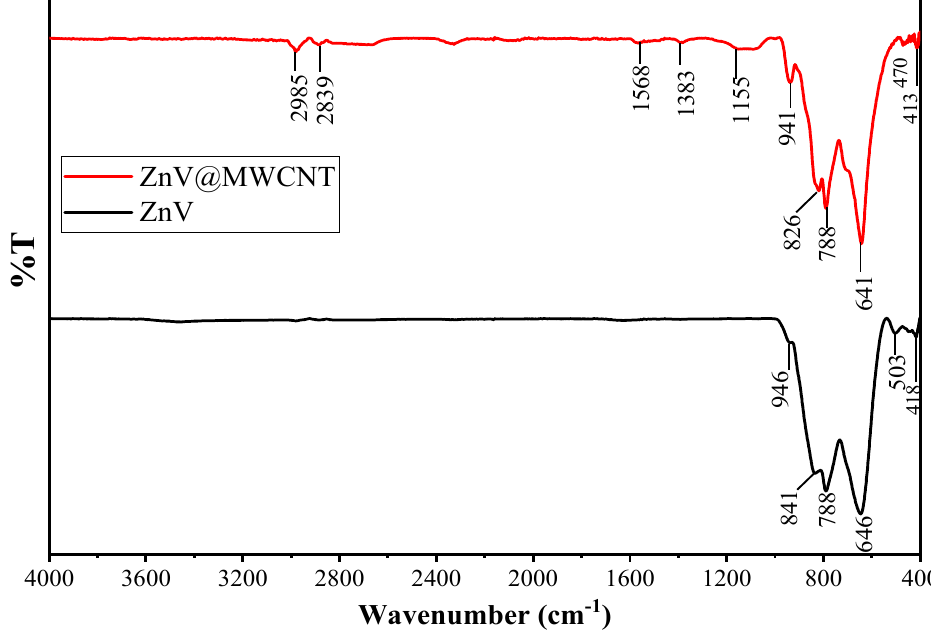
Figure 2. FTIR spectra of ZV (black line) and ZV@MWCNT (red line) calcined at 550 °C.